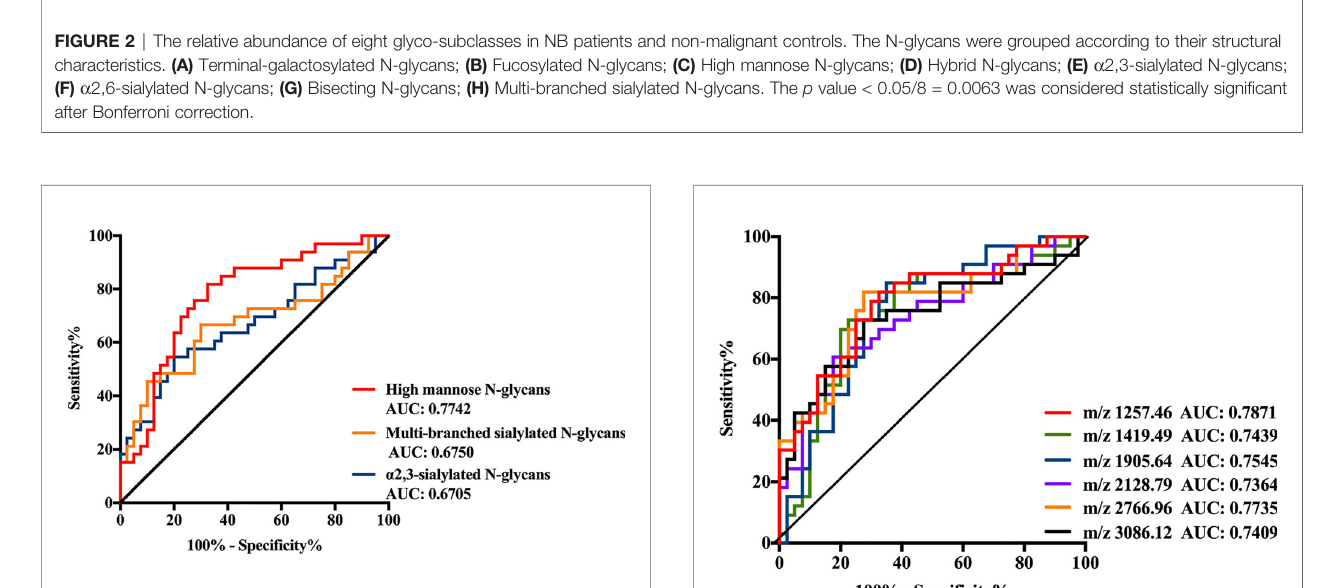
FIGURE 3 | Receiver operating characteristic (ROC) curve analyses for the three signi fi cantly changed glyco-subclasses. The ROC was employed to evaluate the discrimination ef fi ciency of these glyco-subclasses including High mannose N-glycans, a 2,3-sialylated N-glycans, Multi-branched sialylated N-glycans. Their AUC values were 0.7742, 0.6750, 0.6705 respectively. 2766.96: NB vs. Control, 0.0045 to 0.0022; m/z 3086.12: NB vs.